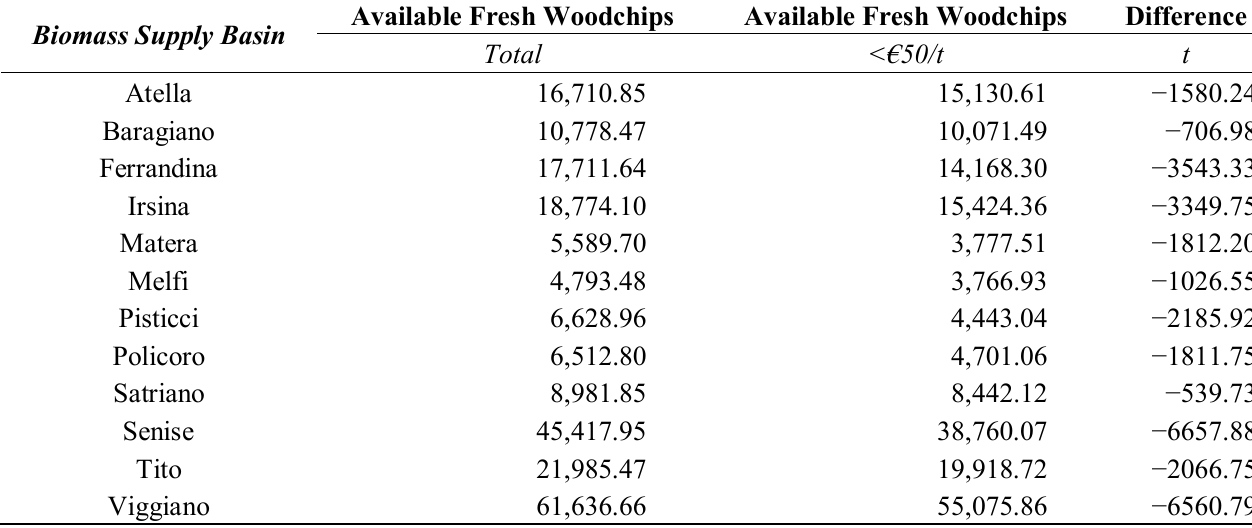
Table 5. Tons of available and utilized woodchips.